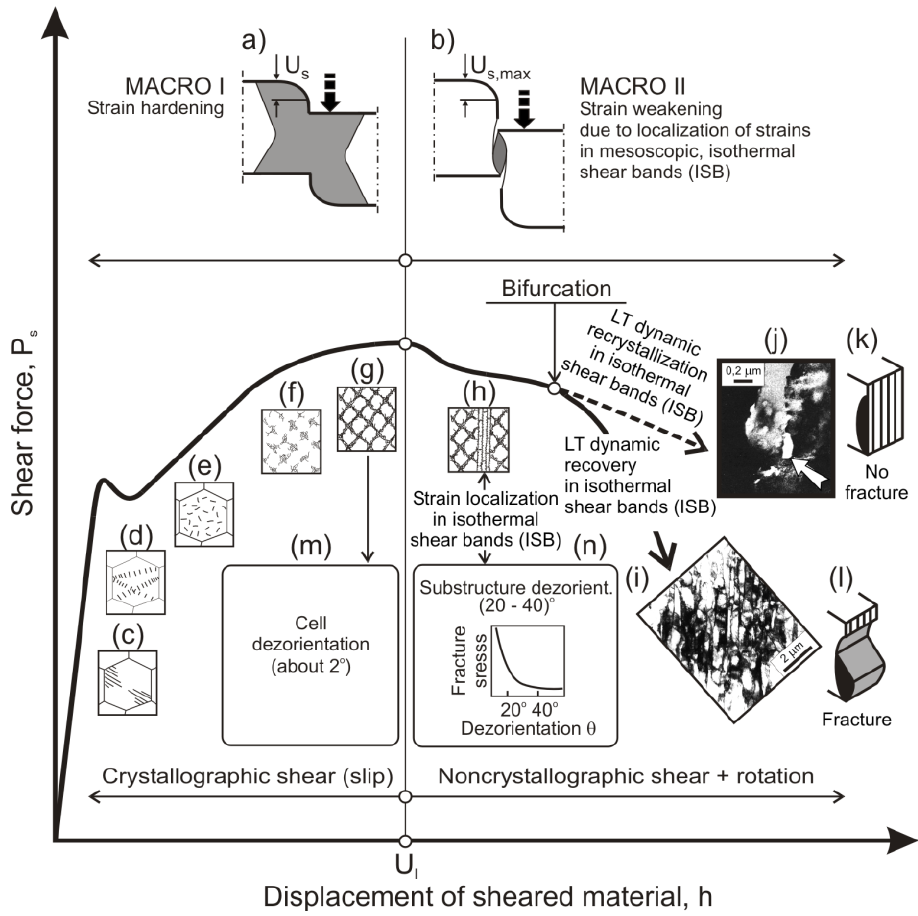
Figure 8. Mesoscopic-macroscopic concept of shearing. According to E.S. Dzidowski. Description in text.